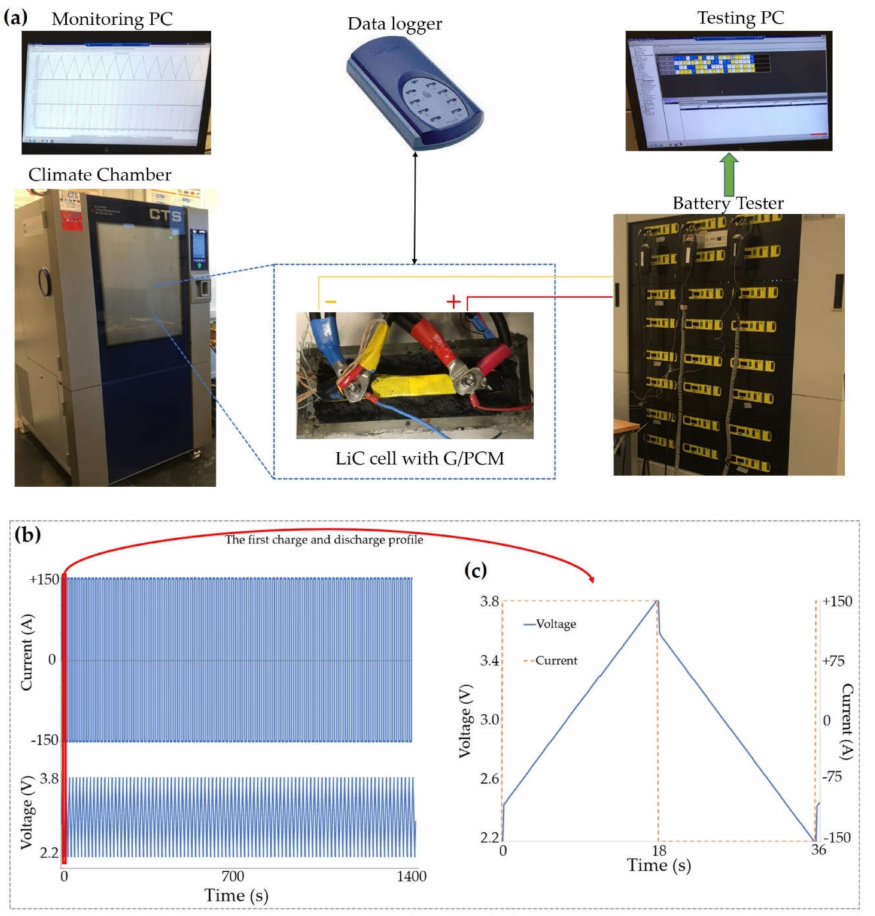
Figure 2. ( a ) Experimental test bench; ( b ) current and voltage profiles with 150 A charge and discharge cycles; ( c ) detailed profile for the first charge and discharge